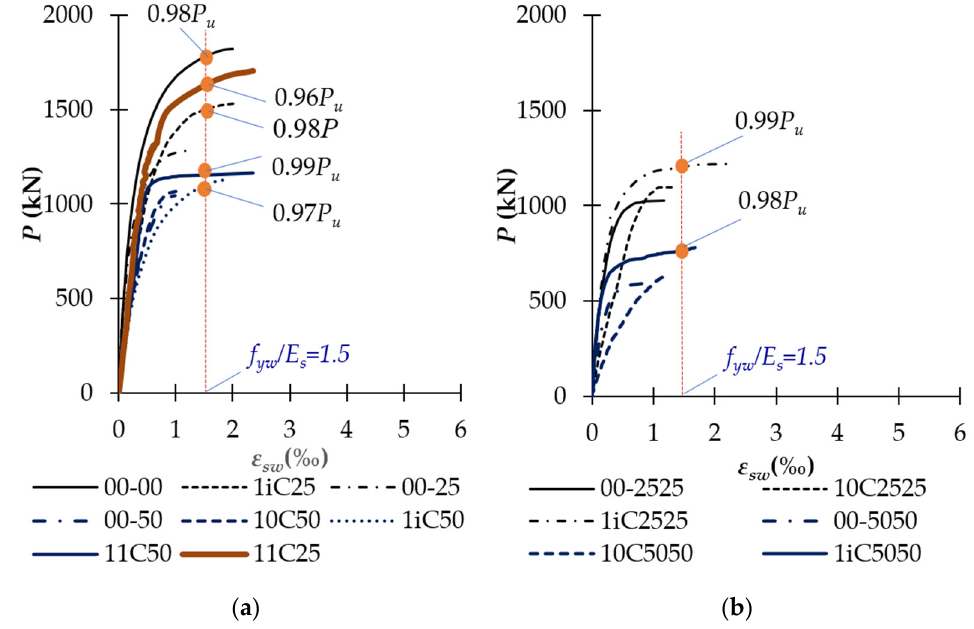
Figure 14. Relationship between the applied load and strain of stirrups: ( a ) Concentrated and uniaxially loaded columns; and ( b ) Biaxially loaded columns.